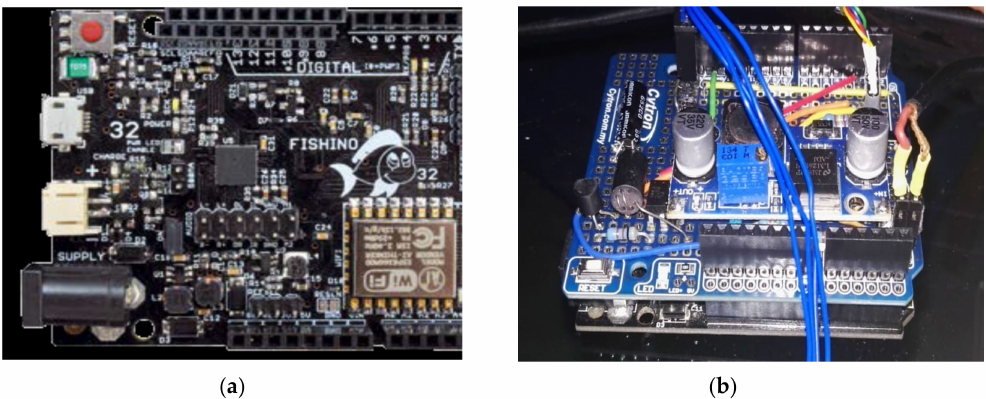
Figure 5. The 32-bit microcontroller unit: ( a ) the Fishino32 board; ( b ) the shield board used in the